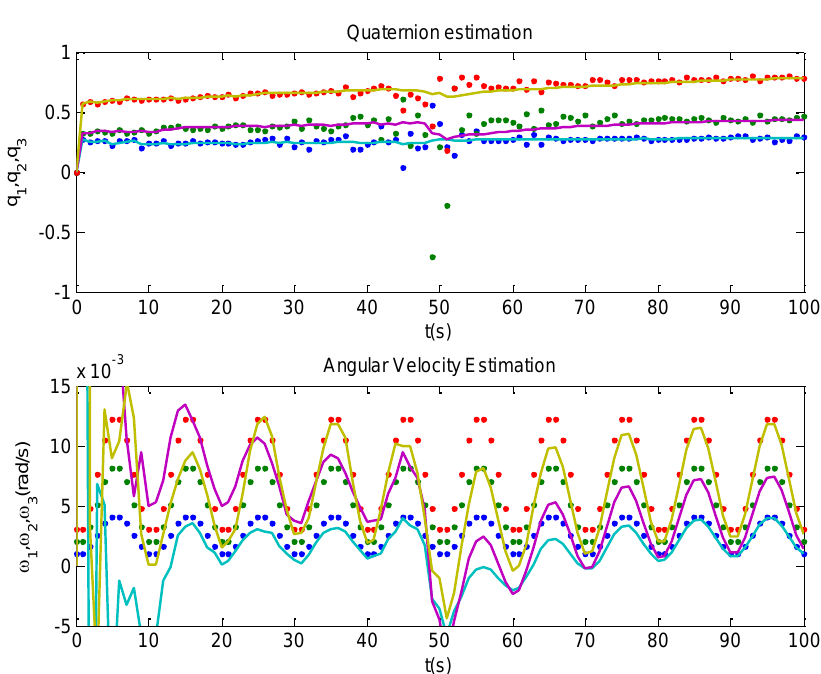
9 of 20 Figure 4. Good vector configuration ( Left ), and ill conditioned vector configuration ( Right ) for determining the attitude. The problem in the configuration on the right side is that a small error in a vector generates a considerable rotation error. In order to visualize the problems related to singularities, a simulated example with just one singularity was devised. This is depicted in Figure 5 where, on top, there is a plot with the determined (dots) and the estimated (solid) quaternions, and at the bottom another plot with the simulated (dots) and estimated (solid) angular velocity. For illustrative purposes, a significant noise has been